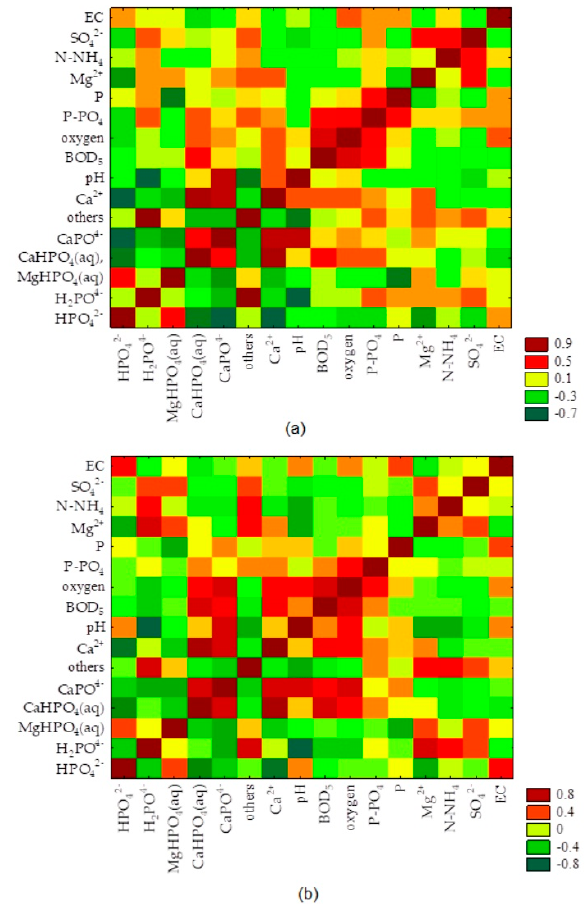
(Figure 9). (Figure 9).